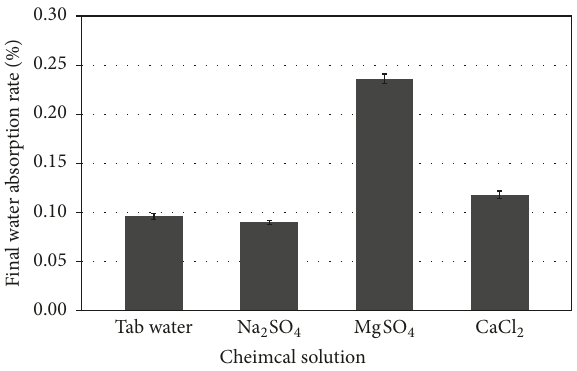
Figure 11: Final absorption rate of hybrid panels.